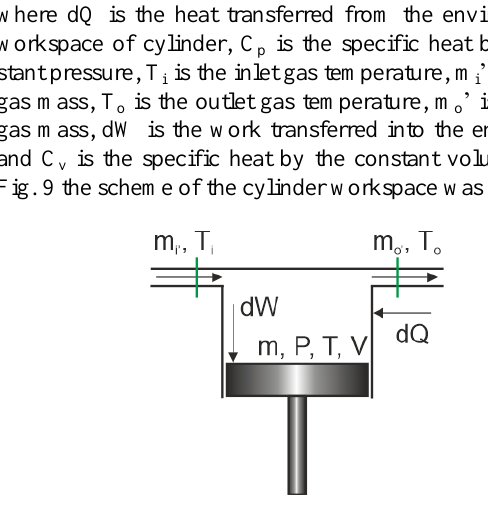
Fig. 9. Scheme of the cylinder workspace [7,